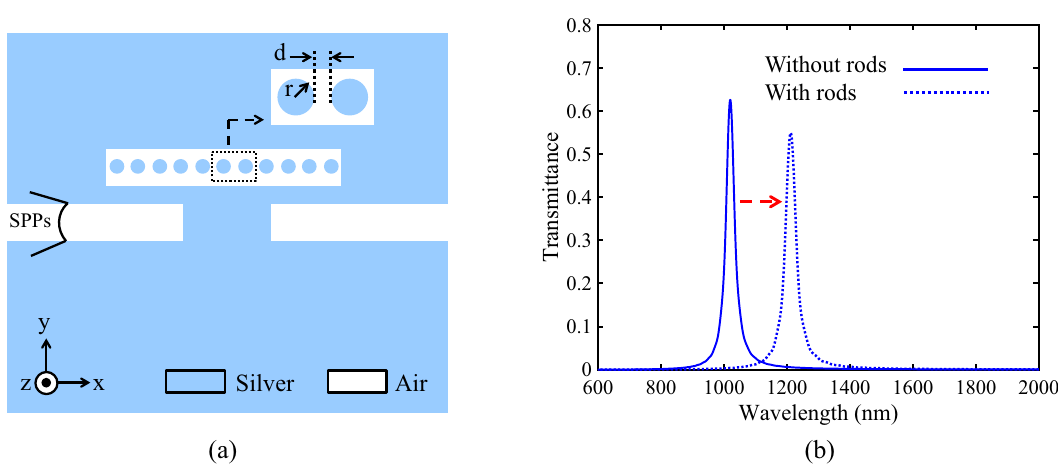
Figure 4. (a) Schematic of the basic filter with silver NRDs. (b) Comparison of the transmission spectrum of the basic filter with and without